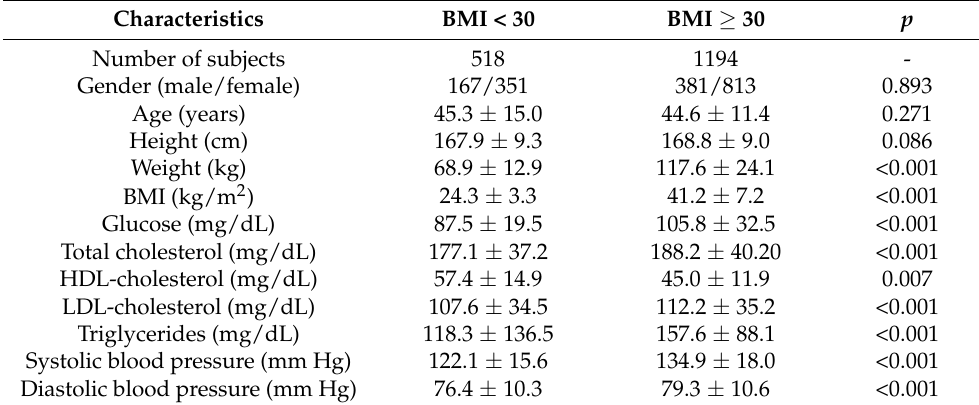
Table 1. Clinical and biochemical characteristics of the study subjects.